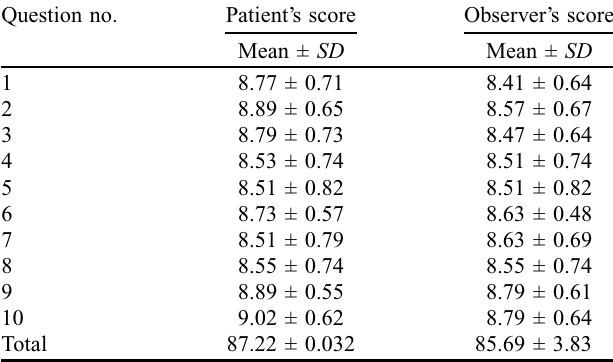
Table 2. Showing mean and standard deviation of patients and observer’s grading of 10 questions. Question no.